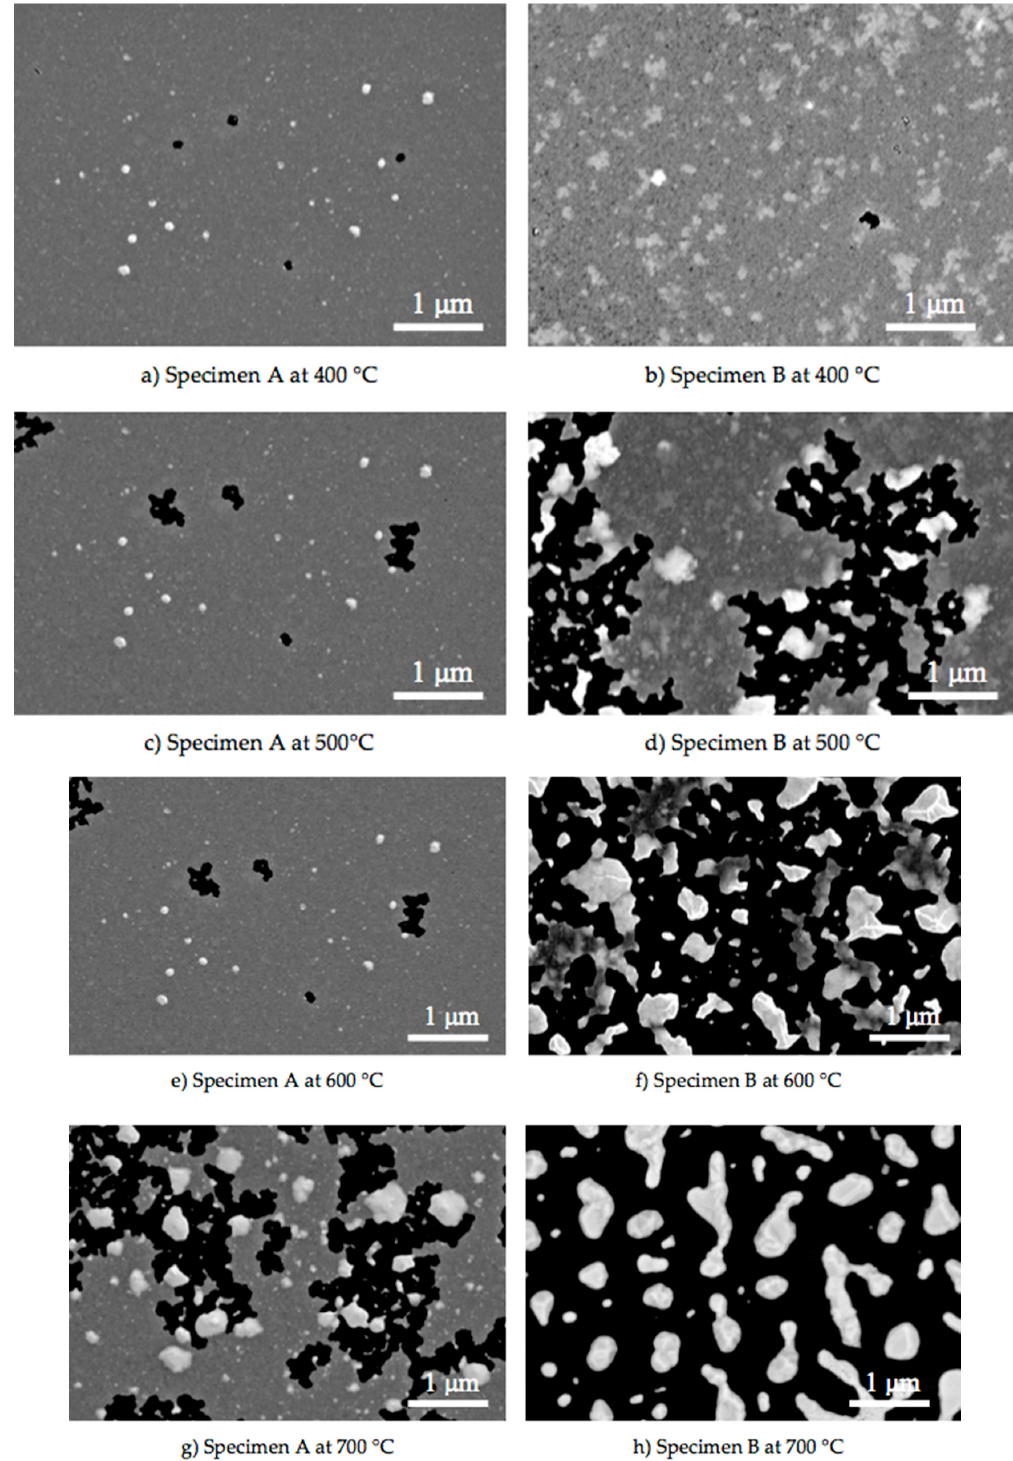
Figure 5. Field emission SEM images for gold nanodot agglomeration on the substrate. ( a ) gold film of specimen A at 400 ◦ C, ( b ) gold film of specimen B at 400 ◦ C, ( c ) gold film of specimen A at 500 ◦ C, ( d ) the void expansion stage of gold film of specimen B at 500 ◦ C, ( e ) gold film of specimen A at 600 ◦ C, ( f ) As these voids grow, they separate the metal film into the islands of specimen B at 600 ◦ C, ( g ) the void expansion stage of gold film of specimen A at 700 ◦ C ( h ) the completely agglomerated of gold nanoisland arrays of specimen B at 700 ◦